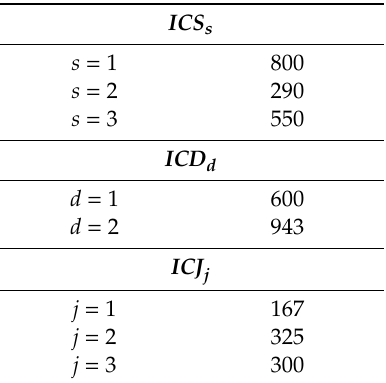
Table A24. Maximum inventory capacity (m 3